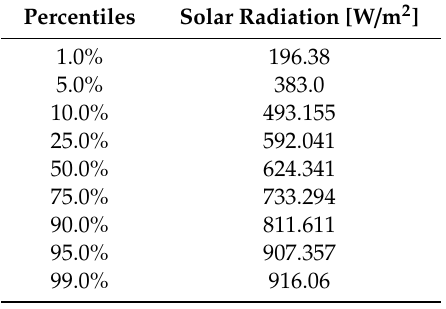
Table 8. Percentiles for solar radiation characterization.